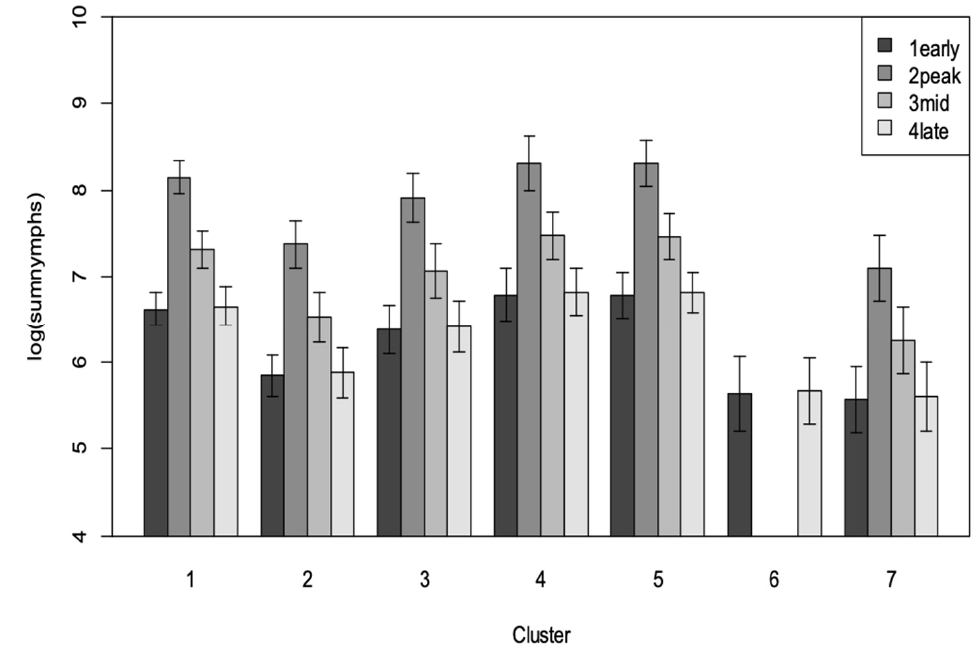
Figure 6. Abundance of B. tabaci SSA1 nymphs by cluster and cassava age (1early = 1–2.5 MAP, 2peak = 3–5 MAP, 3mid = 6–8 MAP, 4late = 9–12 MAP).